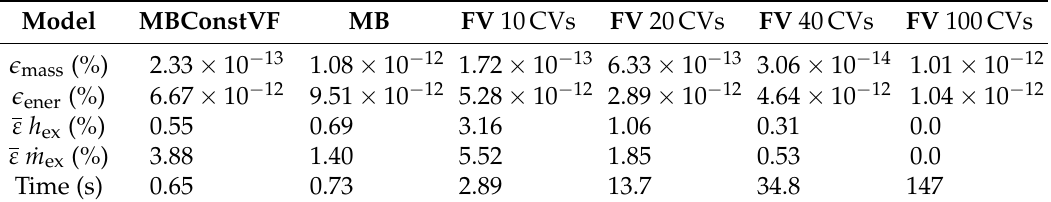
Table 2. Benchmarking indicators for the integrity and accuracy test for the moving boundary and the finite volume models. MBConstVF, moving boundary with the constant void fraction; FV, finite volume.